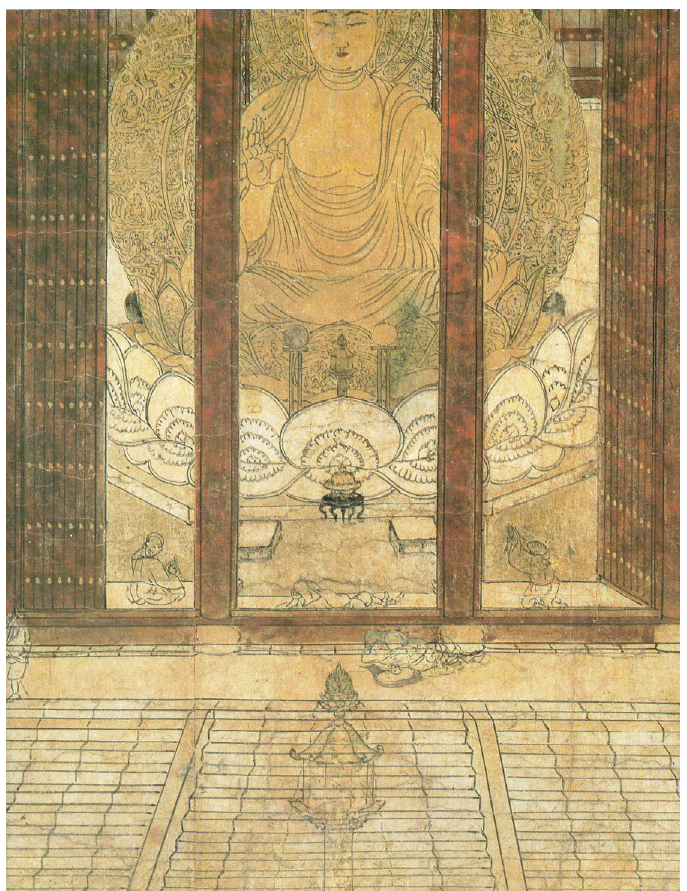
Figure 4. The original bronze and stone double pedestal of the Great Buddha, Tōdaiji. Excerpt from the Illustrated Origin of Mt. Shigi ( Shigisan engi emaki ). Heian period, 12th century. Chōgosonji, Nara prefecture. Reproduced from (Murashige 1991, plate 9).